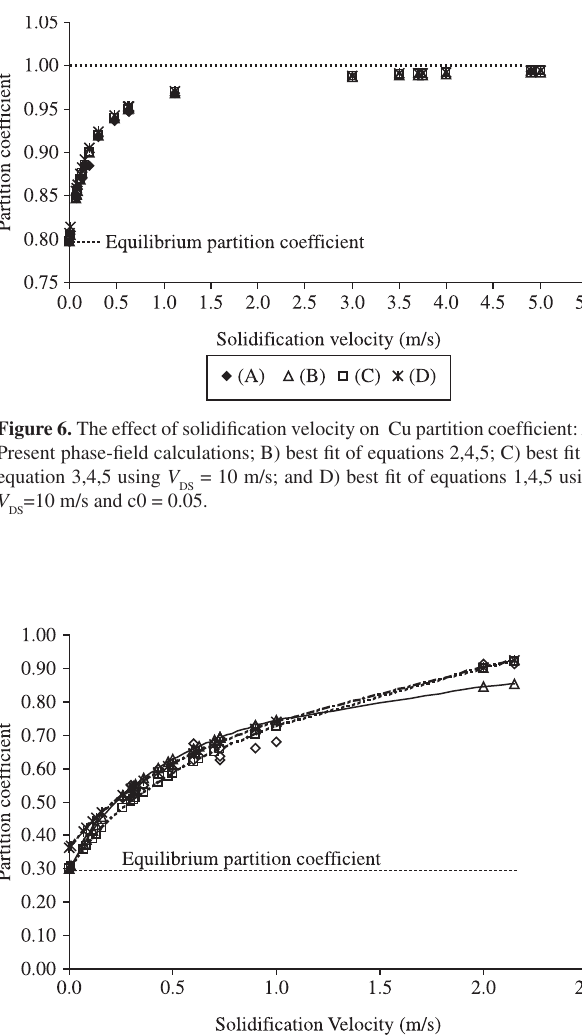
equal to 1.5; st